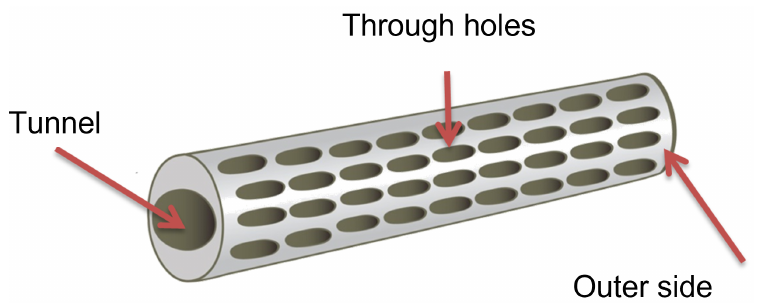
Figure 1. Geometrical features of orthopedic